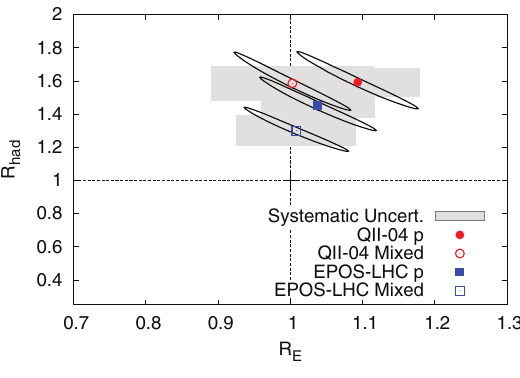
Figure 7. Best-fit values of R E and R had for QGSJetII-04 and EPOS-LHC, for pure proton (solid circle, square) and mixed composition (open circle, square). The ellipses and gray boxes show the 1- σ statistical and systematic uncertainties.